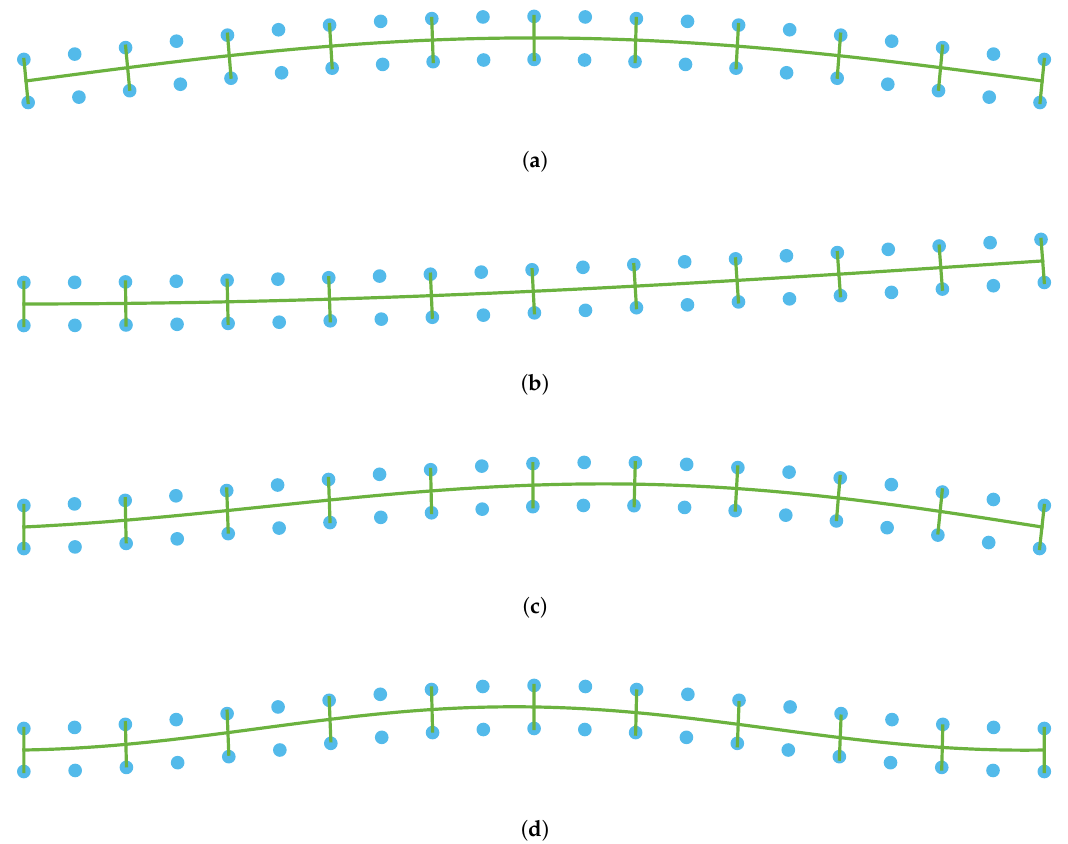
Figure 6. Critical mode in the case study II, when n = 20, and for different boundary conditions: ( a ) H-R; ( b ) C-F; ( c ) C-R; ( d ) C-S. Continuous green curve: Timoshenko model; blue dots: FE